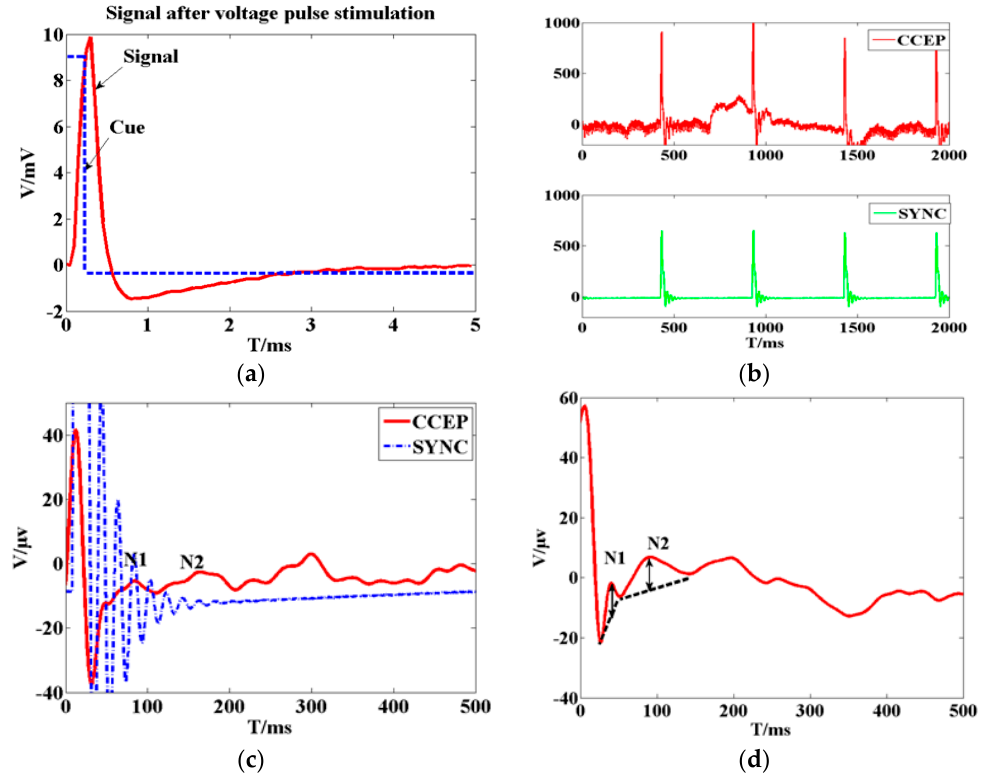
Figure 1. ( a ) The recording voltage in primary visual cortex by glass tungsten electrode when sub-threshold voltage pulse stimulus was delivered on the ipsilateral dura mater by external wired stimulator device. The blue dash line shows the square pulse stimulus with 200 µs pulse width and 400 mV. The red line waveform shows the recording signal with peak voltage of 10 mV. The result shows that stimulus on the dura mater can be transferred to cortical tissue; ( b ) Original cortico-cortical evoked potential (CCEP) (in red color) recorded on unilateral visual cortex when voltage stimulus was delivered on the contralateral dura mater by the wireless stimulator device. The green trace is for stimulating synchronization signal that output from the external transmitter; ( c ) Cortical evoked potential after averaging and filtering; ( d ) Typical configuration of CCEPs.